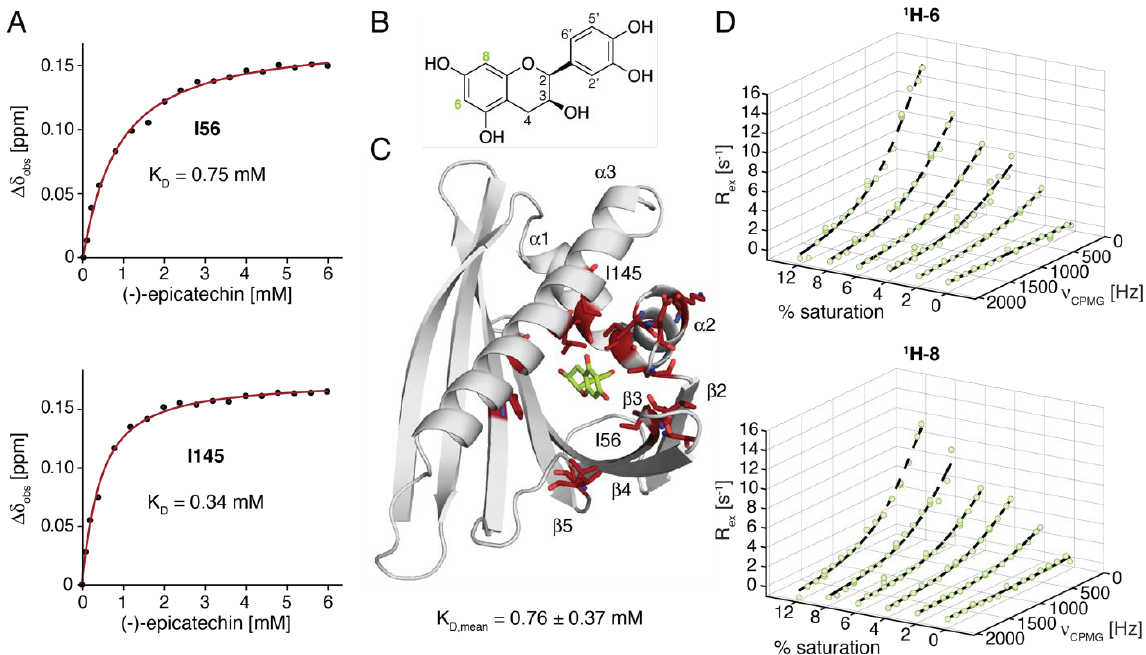
Figure 5. NMR spectroscopic analysis of binding of ( – ) – epicatechin to Ara h 8.0101. ( A ) Binding curves for two representative amino acid residues (Ile56 in strand β 3, and Ile145 in helix α 3). Site- specific K D values were derived from ligand-induced 1 H and 15 N chemical-shift perturbations ( Δδ obs ) by nonlinear least-squares fitting [33]. ( B ) Structure and numbering scheme of ( – ) – epicatechin. ( C ) X-ray structure of Ara h 8.0101 in complex with ( – ) – epicatechin (PDB: 4MA6). Amino acid residues in red show backbone amides with Δδ obs > 0.1 ppm upon (-)-epicatechin binding that were used to determine mean value and standard deviation of K D . ( D ) Ligand-observed 1 H – CPMG relaxation- dispersion profiles, recorded at 600 MHz, for (-)-epicatechin binding to Ara h 8.0101. Data are shown for protons 1 H – 6/8 (indicated in green in panel ( B )), and for increasing saturation (0 – 12%) of the ligand by protein. Solid lines represent the global fit to the data, yielding the off-rate (k off ) of the (-)-epicatechin from the complex.